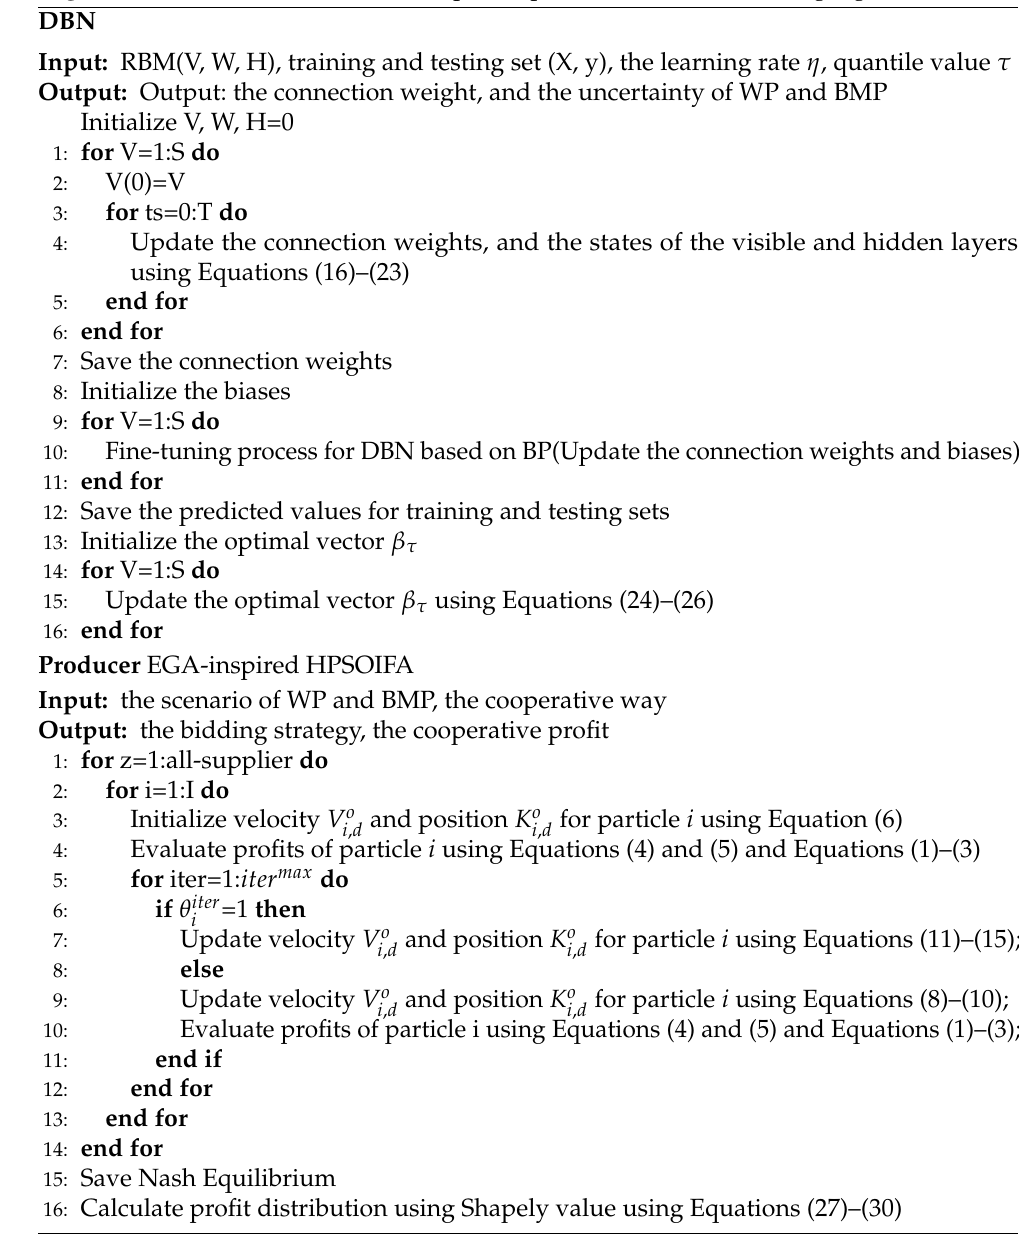
Algorithm 1 Pseudocode of the wind power producers’ market bidding